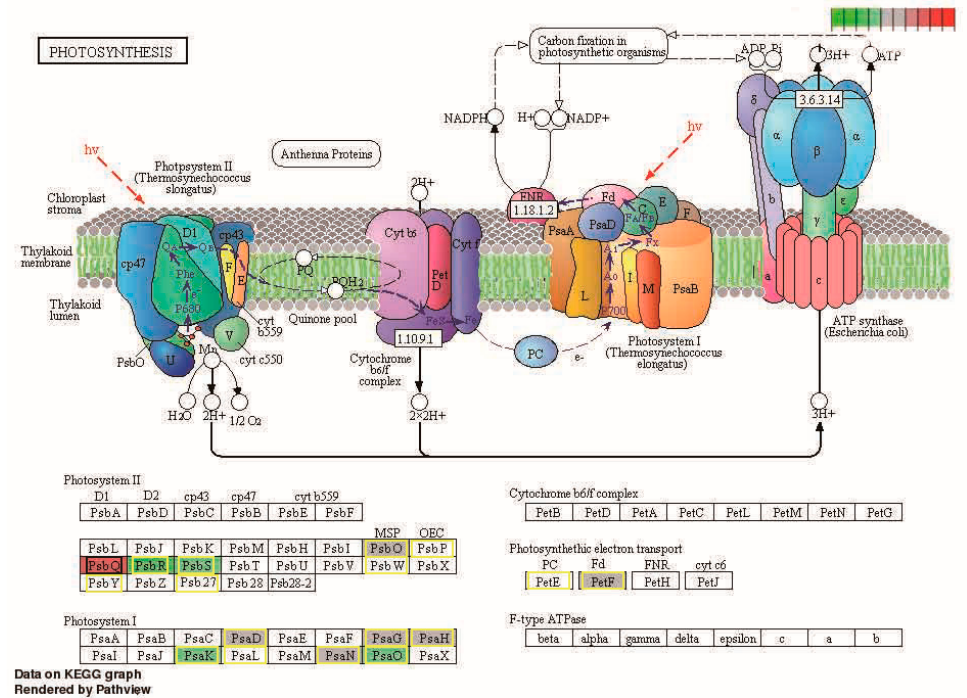
Figure 6. KEGG enrichment pathway of differential expression genes in the photosynthetic system. Black and yellow boxes indicate up-regulated and down-regulated genes, respectively.